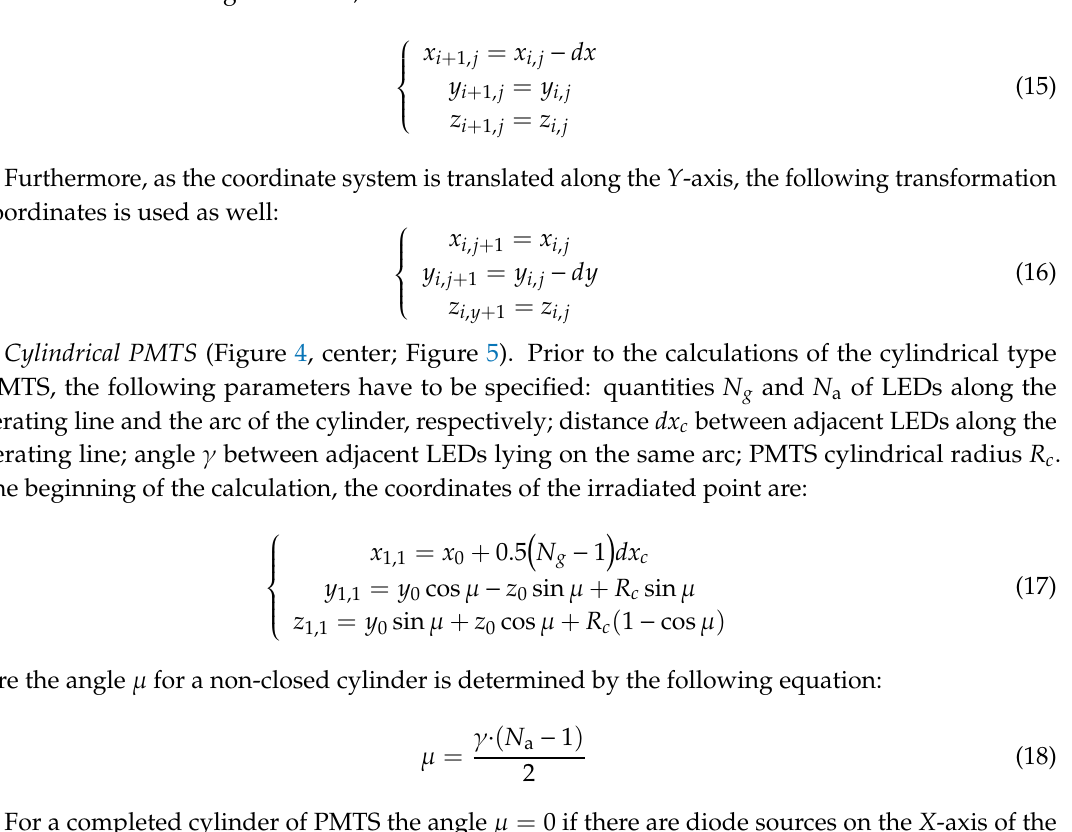
Figure 4. Three general types of PMTS (flat, cylindrical and spherical) and position of basic coordinate system for calculation of PMTS illuminance.